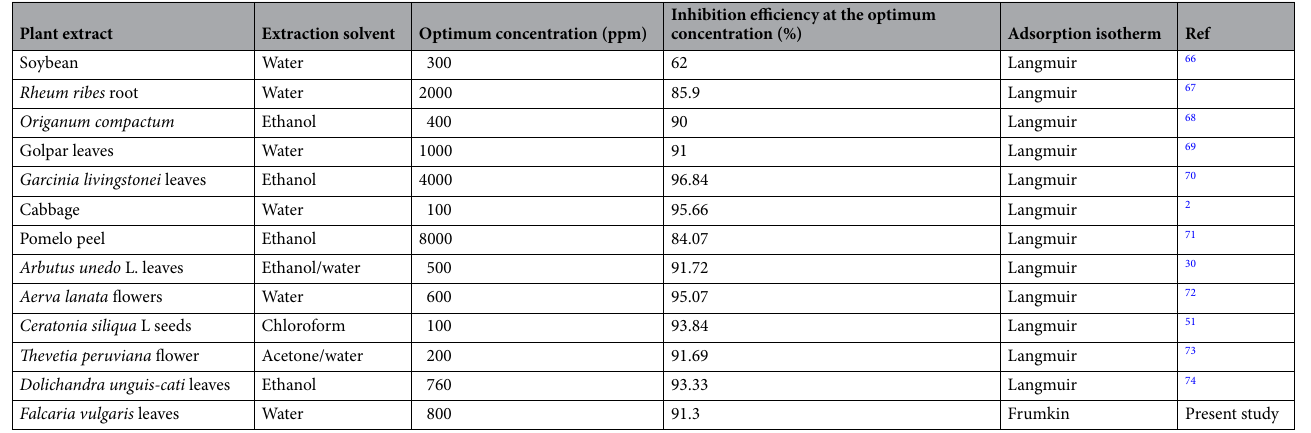
Table 6. Comparison between different plant extract used as corrosion inhibitor for MS in HCl